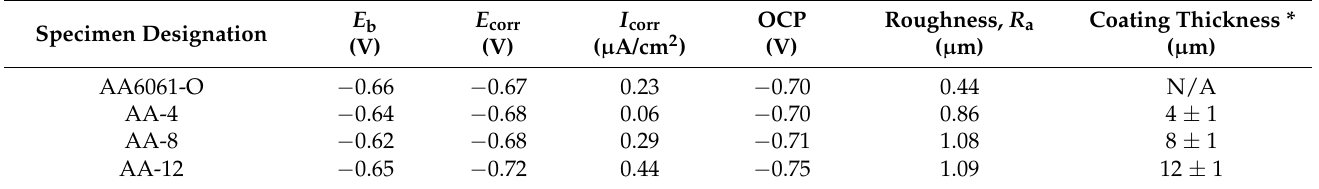
Figure 3. Potentiodynamic DC linear polarization curves of all tested specimens in 1 M NaCl cor- corrosive media. rosive media. Table 3. Compiled results for investigated Table 3. Compiled results for investigated specimens.